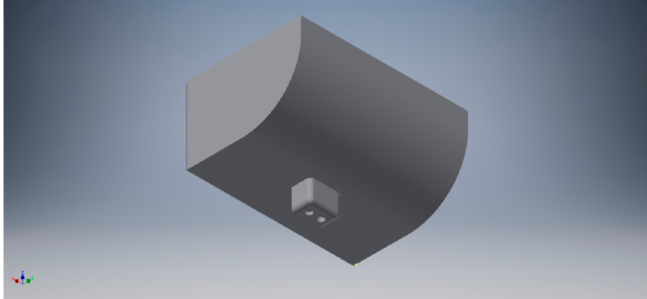
Figure 12. 3D rendering of the assembly between a coin compartment and the workpiece designed for the union between compartments and load cells.